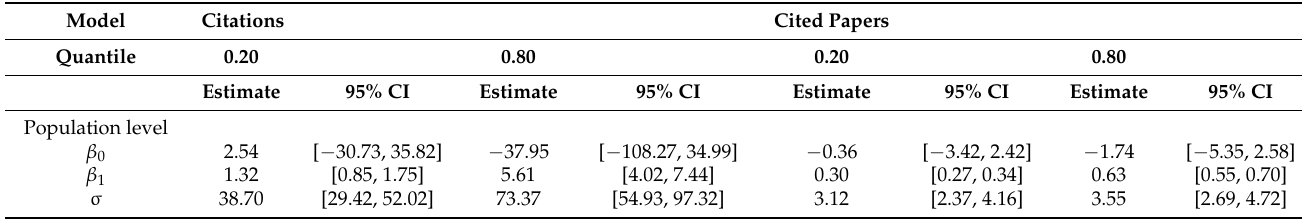
Table notes. CI = credible interval.